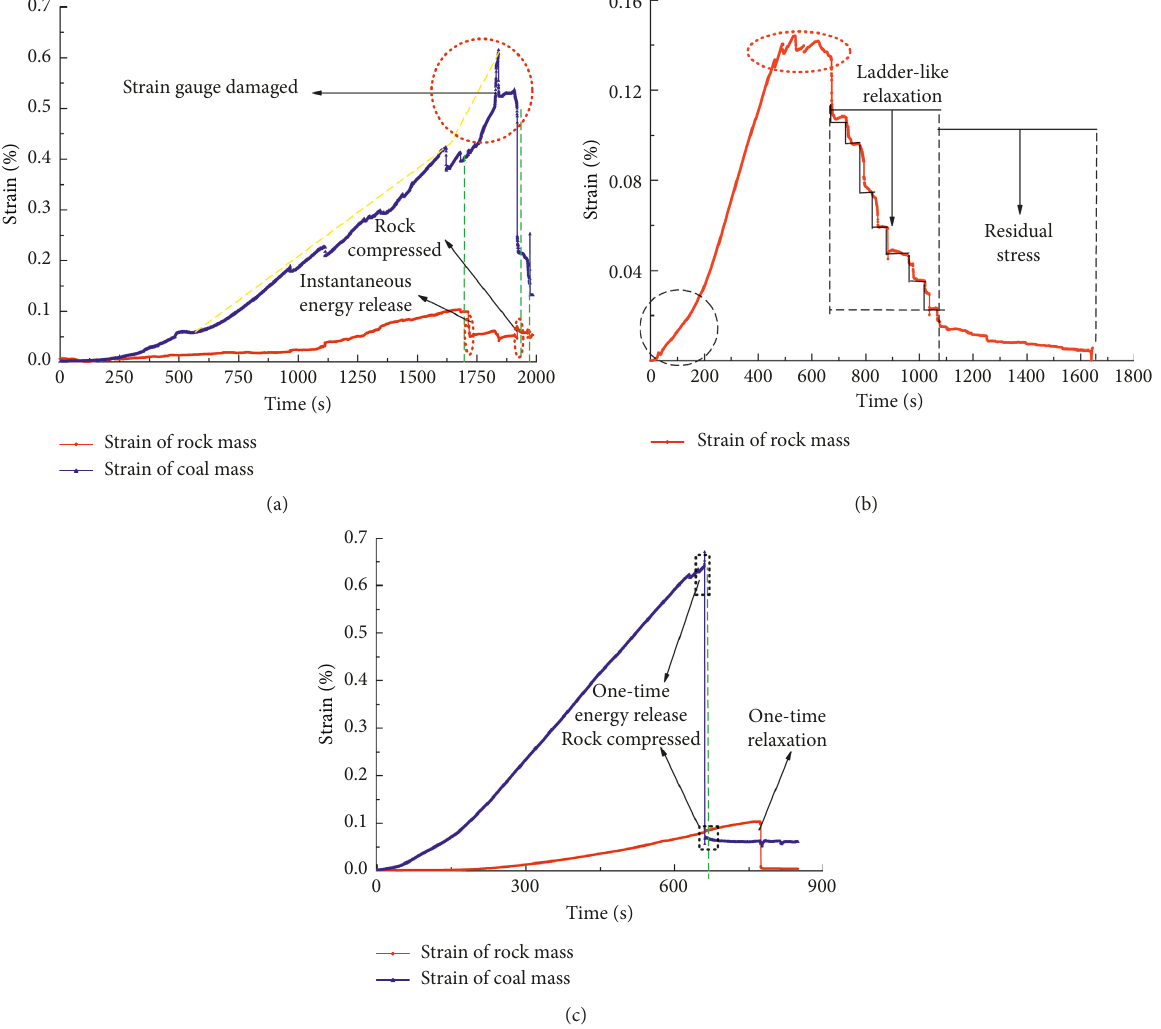
Figure 7: Axial strain curves: (a) intermediate sample (3 # ); (b) step-shaped strain release of rock mass (4 # ); (c) one-time strain release of rock mass (5 #